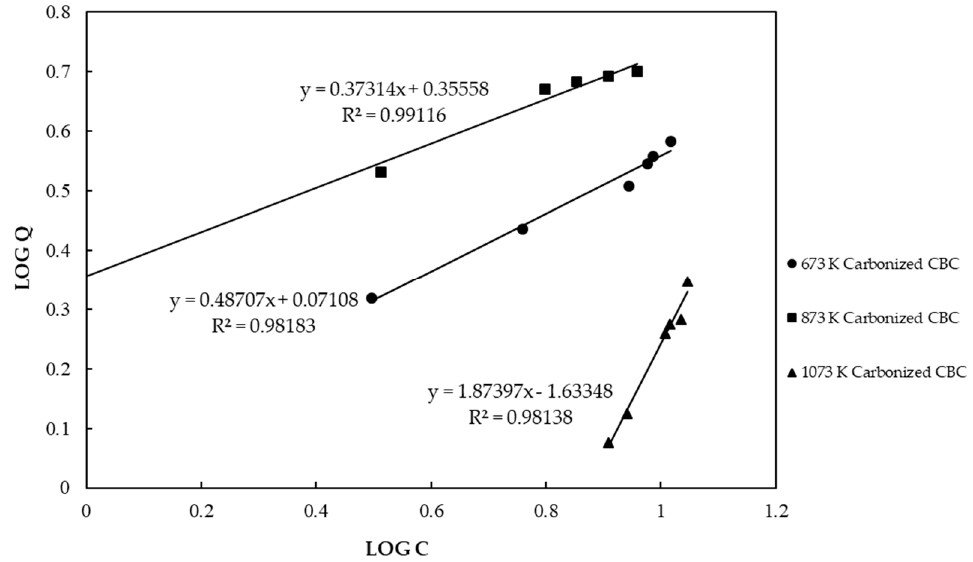
Figure 2. Freundlich isotherm for chicken bone char (CBC) carbonized at different